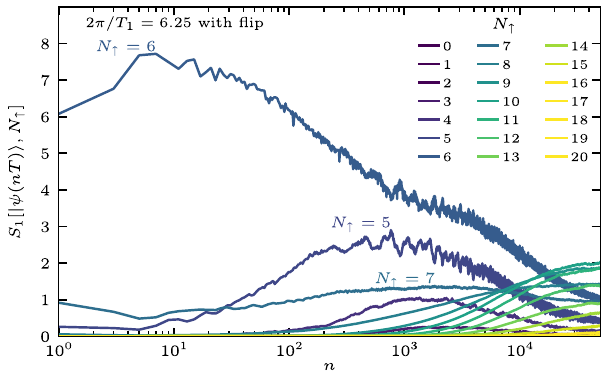
FIG. 3. Time dependence of the sector (labeled by the number of up spins N ↑ ) resolved participation entropy S 1 ½j ψ ð nT Þi ; N ↑ (cid:2) of the wave function j ψ ð nT Þi starting from the initial state j 00100100100100100100 i (i.e., in the sector with N ↑ ¼ 6 ) under the NMR Floquet drive with a frequency of ω ¼ 6 . 25 , hT 1 ¼ π , and an approximate global spin flip after each period θ ¼ π þ ϵ with ϵ ¼ 0 . 18 . The wave function spreads quickly within one sector, before slowly spreading over several